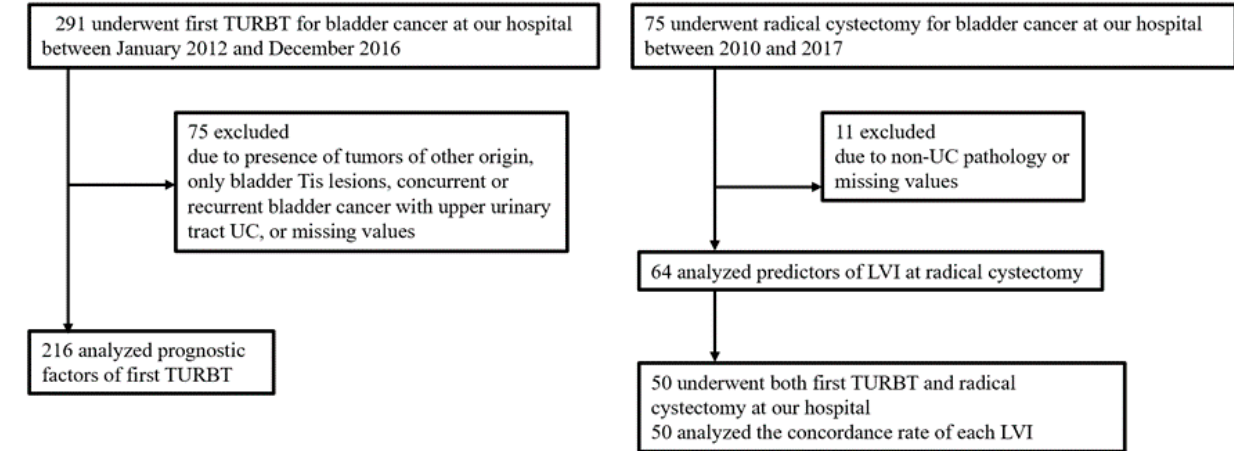
Figure 1. Flow chart for patient selection. TURBT: transurethral resection of bladder tumor; UC: urothelial carcinoma; LVI: lymphovascular invasion.